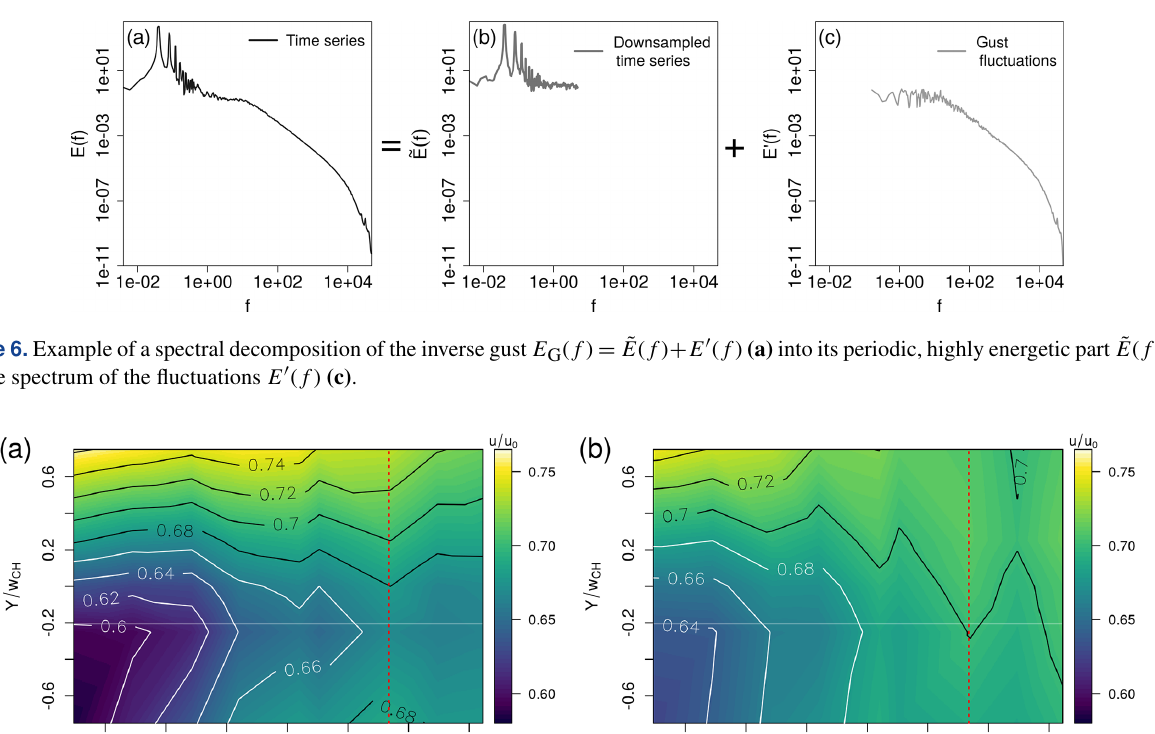
Figure 7. Interpolated surface plot of the downstream evolution of the mean velocity of the inverse gust for (a) f CH = 0 . 4Hz. The red dashed line marks the downstream position of the YZ (b) f CH 2